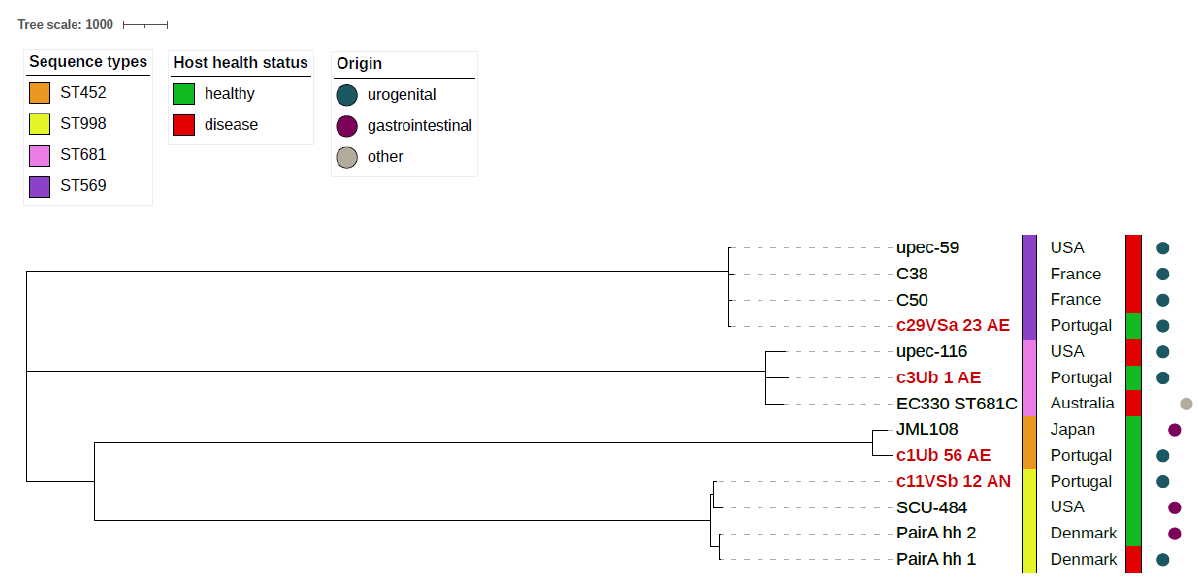
Figure 5. Whole genome SNPs phylogenetic tree of 4 infrequent E. coli STs (ST452, ST569, ST681, ST998) including 4 from our urogenital collection (marked in red) and 9 genomes retrieved from NCBI database. The alignment was performed using E. coli strain 536 as a reference. The tree is unrooted. Information on ST, health status of the host and origin of the strains is incorporated in the tree.